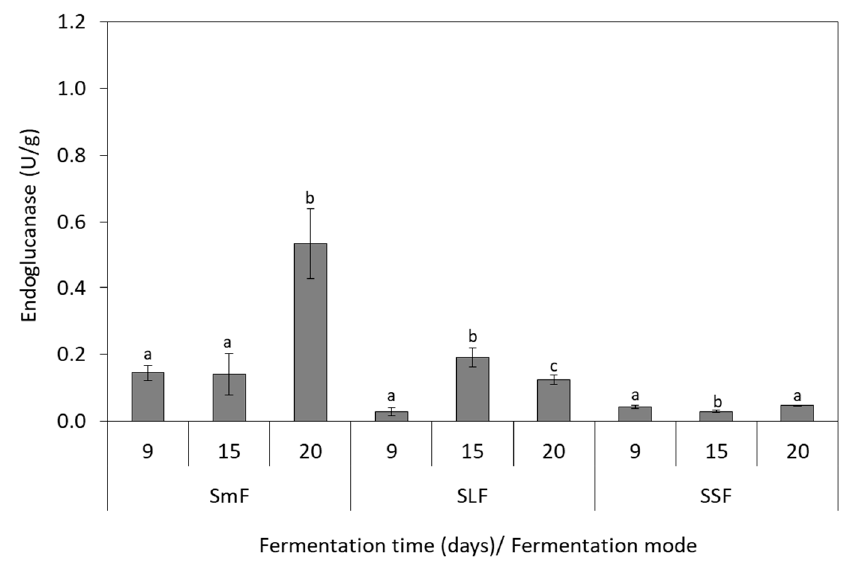
Figure 5. Production of endoglucanase by P. pulmonarius during solid-state (SSF), submerged (SmF), and semiliquid (SLF) fermentations using grape pomace as substrate. Different letters indicate significant differences ( p < 0.05) between fermentation days for each fermentation mode.